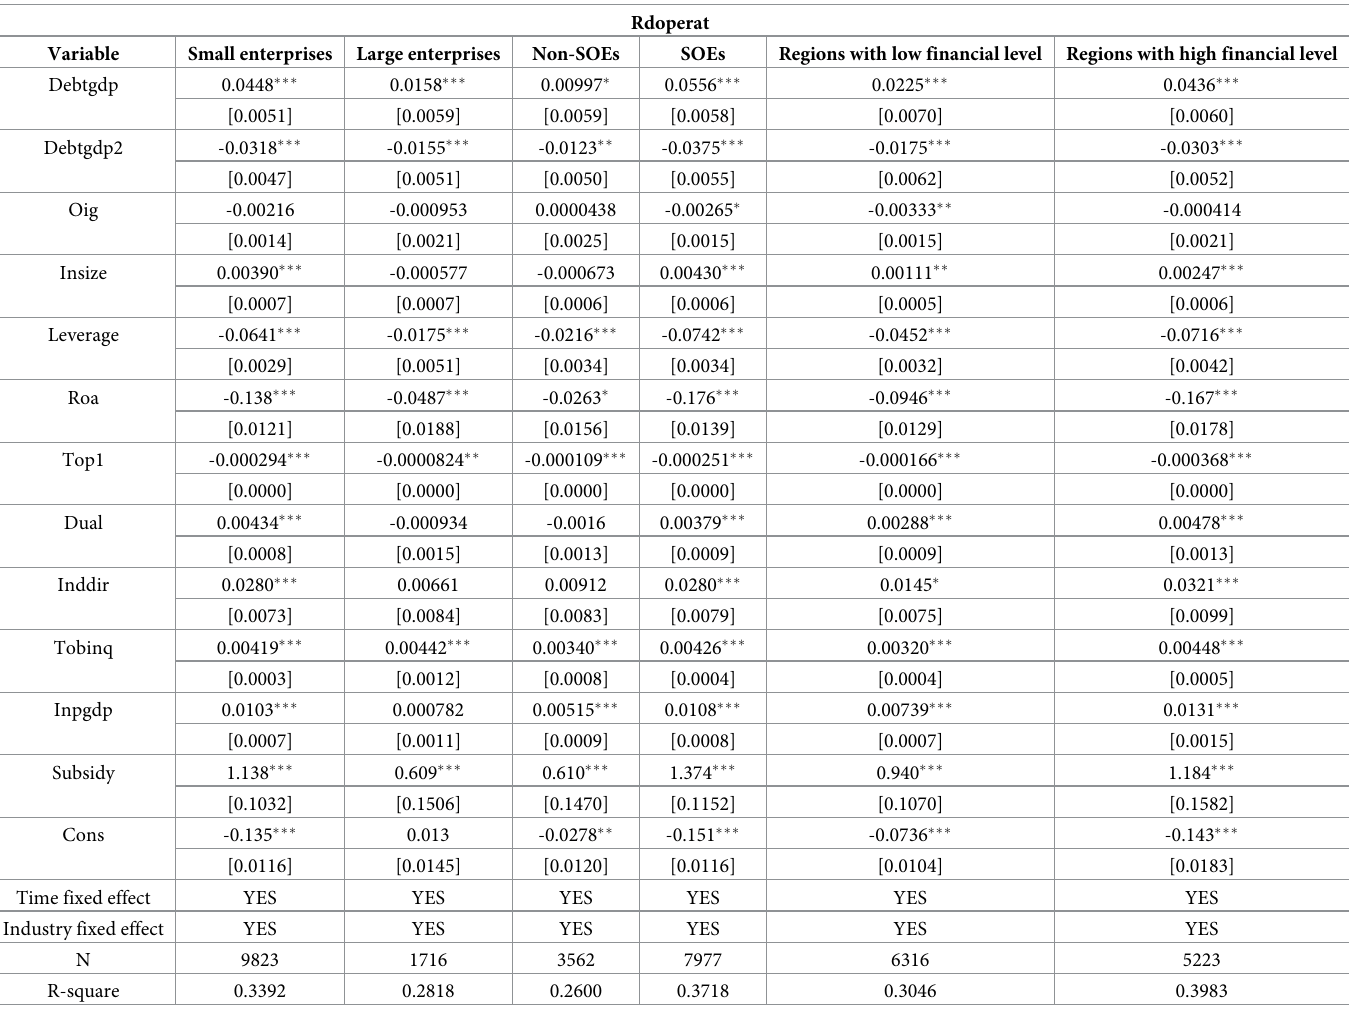
Table 5. Regression results of heterogeneity